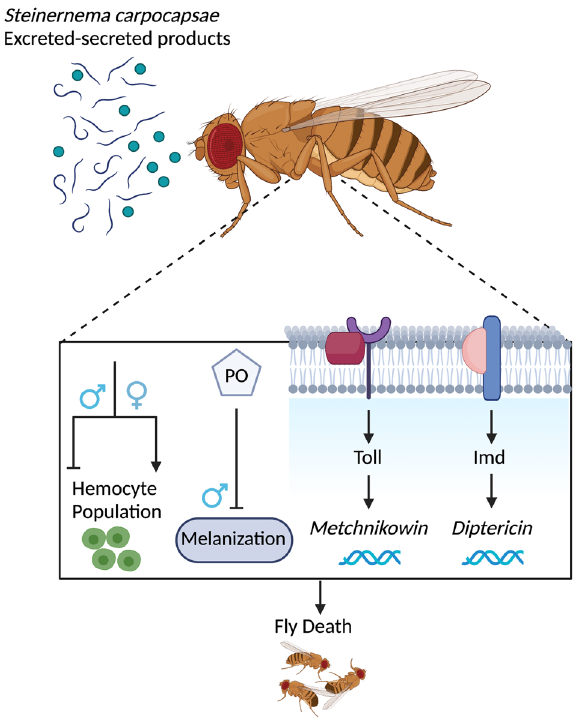
Figure 7. Impact of the Steinernema carpocapsae nematode excreted/secreted products (ESPs) on the Drosophila melanogaster immune response. Summary of the effects S. carpocapsae ESPs on the D. melanogaster immune system. Injection of the nematode infection factors reduces fly survival rates, activates the Immune Deficiency (Imd) and Toll signaling pathways, reduces the phenoloxidase (PO) enzyme activity, delays the melanization response in male flies, and alters hemocyte numbers in male and female individuals. All figure drawings were made using